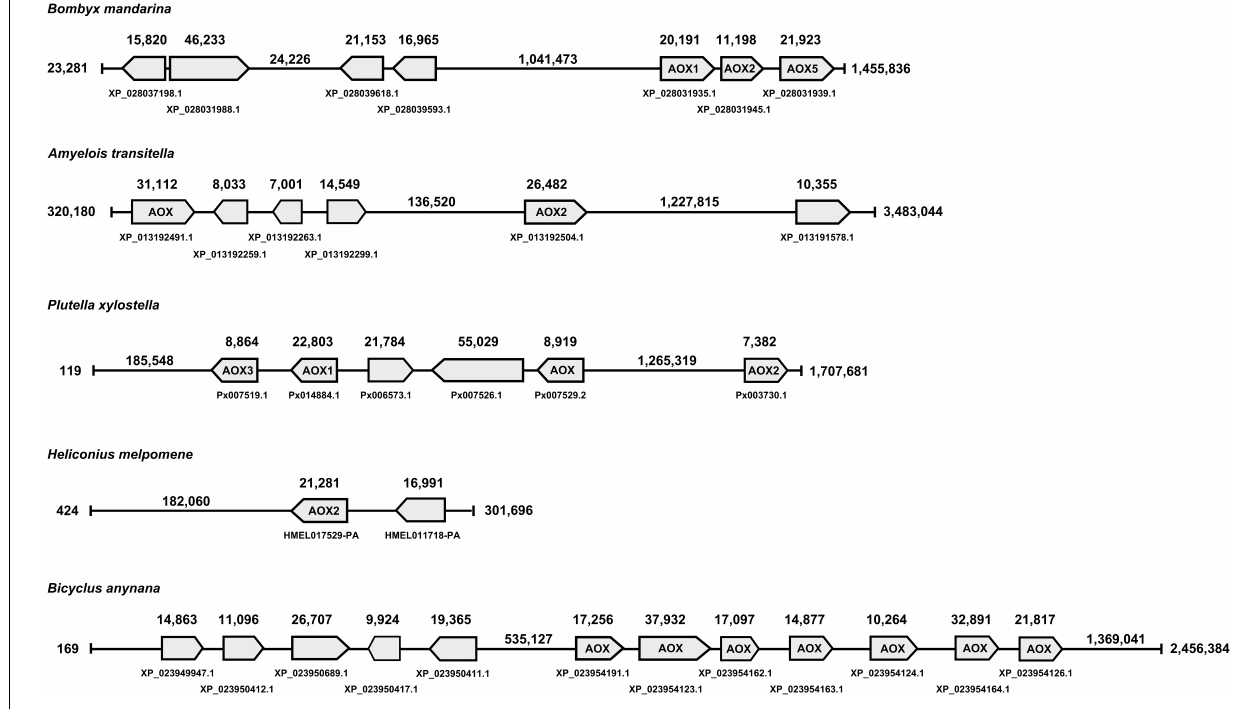
Frontiers in Ecology and Evolution |